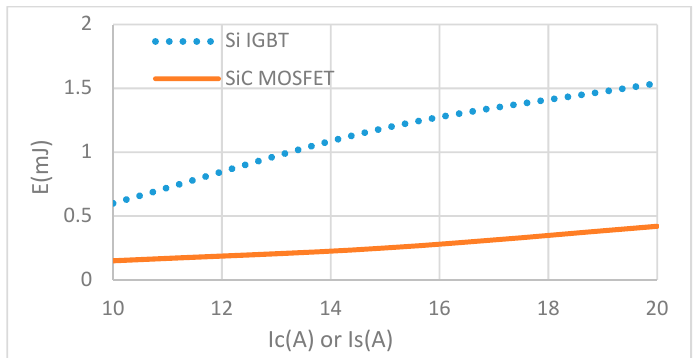
Figure 4. Switching energy curves of silicon (Si) IGBT and silicon carbide (SiC) MOSFET at 25 °C.